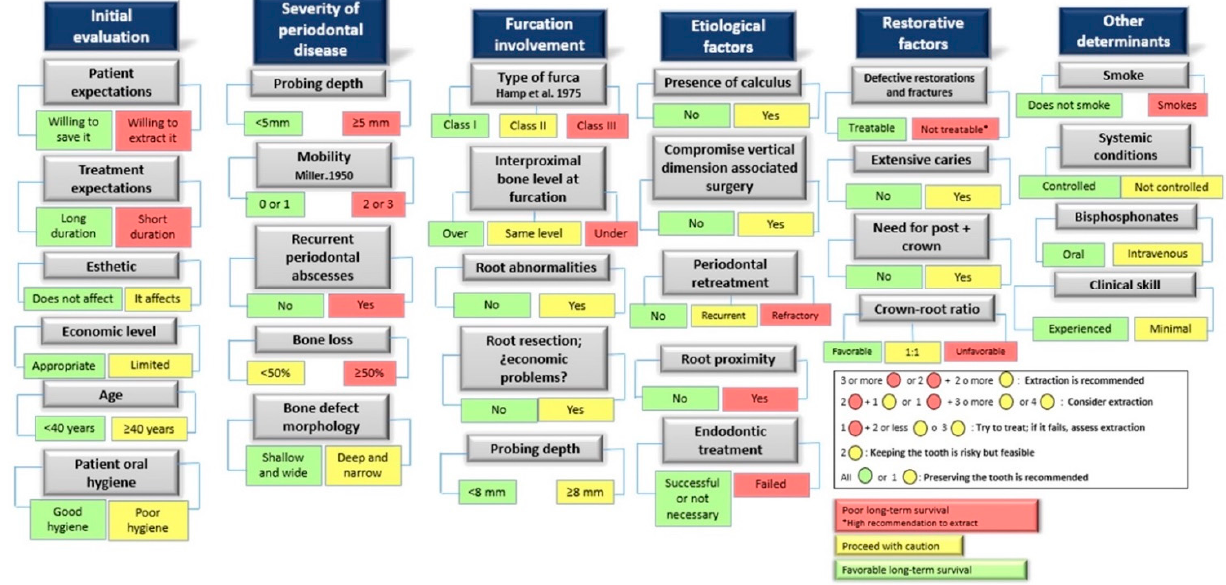
Figure 2. Schematic diagram of the main factors that should guide decision-making to maintain or extract a tooth from a periodontal point of view. Based, with modifications made by the authors, on the schemes initially proposed by Avila, G. et al., 2009 [39]; Nunn, M.E. et al., 2012 [35].